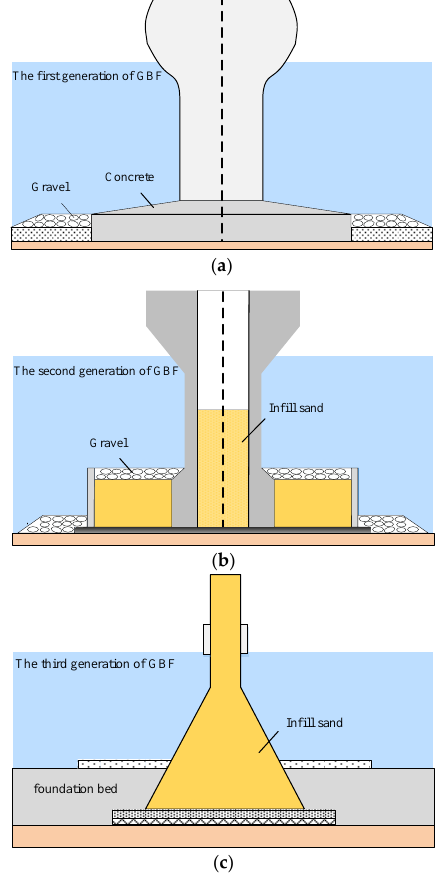
Figure 2. The existing GBF for a wind turbine structure: ( a ) GBF for water depth less than 10 m; ( b ) GBF for water depth about 10~20 m; ( c ) GBF for water depth greater than 20 m.